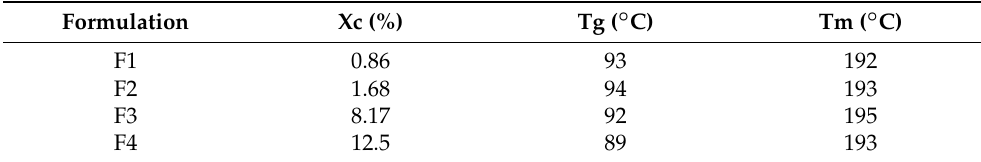
Table 1. Crystallinity index from XRD (Xc), Tg, and endothermic peaks for the electrospun nanocom-